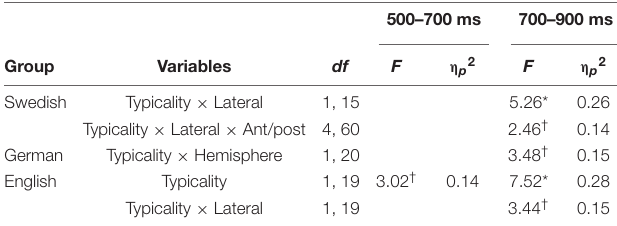
TABLE 5 | F -values for follow up analyses of group ERP effects to Swedish placement